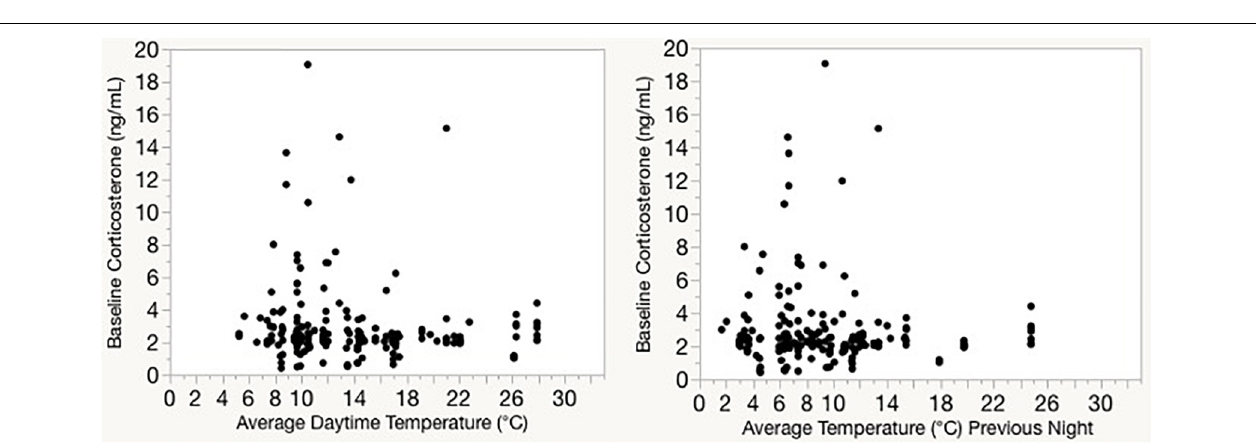
FIGURE 5 | Baseline corticosterone vs. 24 h average temperature prior to blood sampling in captive ( A , with repeated samples identified by bird ID) and field ( B , with each point reflecting a unique bird ID). Aviary temperature was measured via thermistors placed on the cage, while field temperature was recorded by a local weather station.